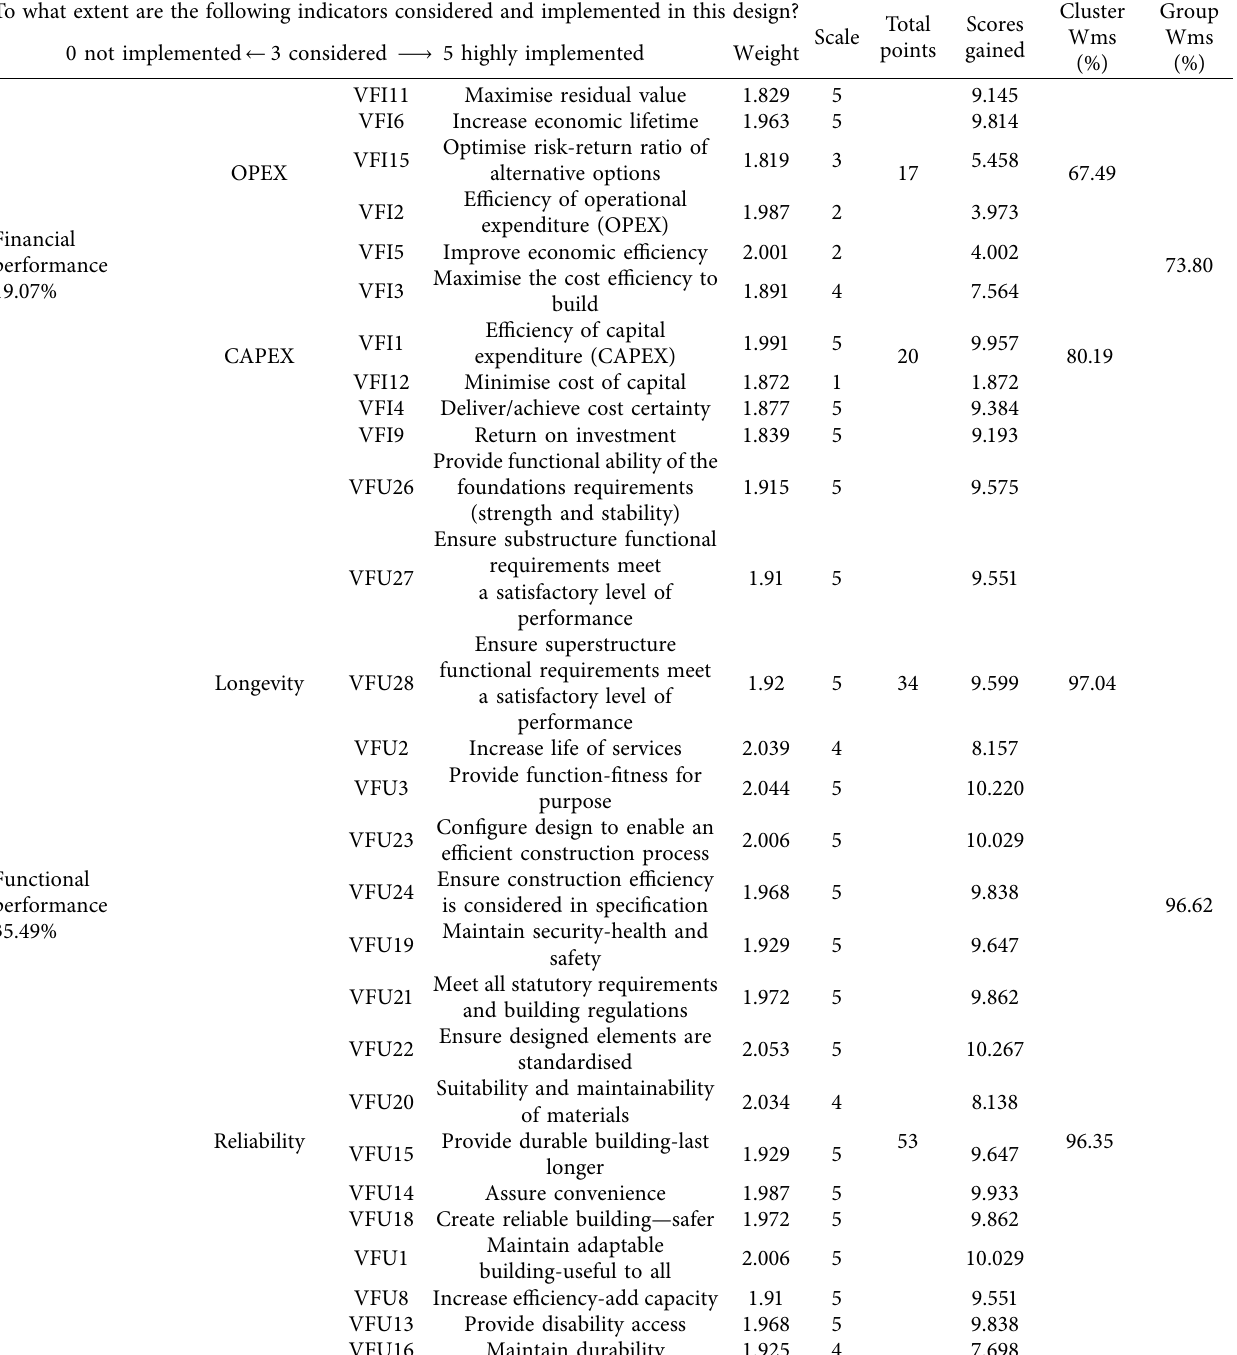
Table 8: Building three value assessment tool